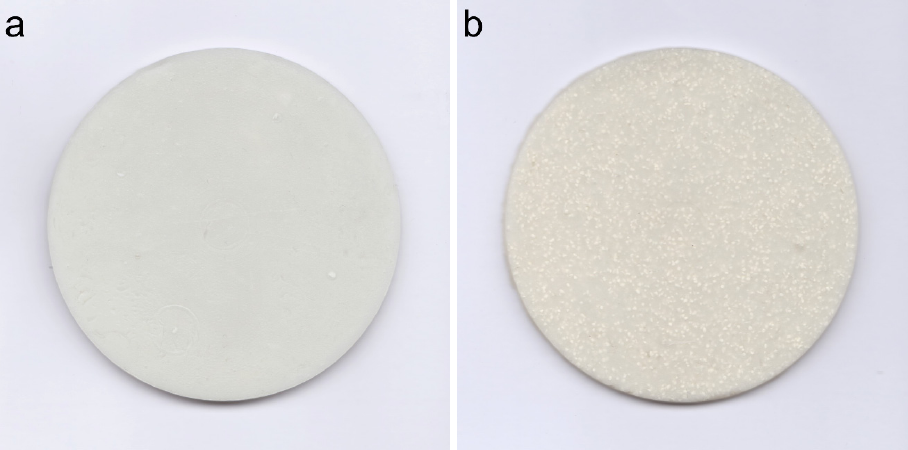
Figure 1. Appearance of the ( a ) unmodified PMMA bone cement and ( b ) MC modified PMMA bone